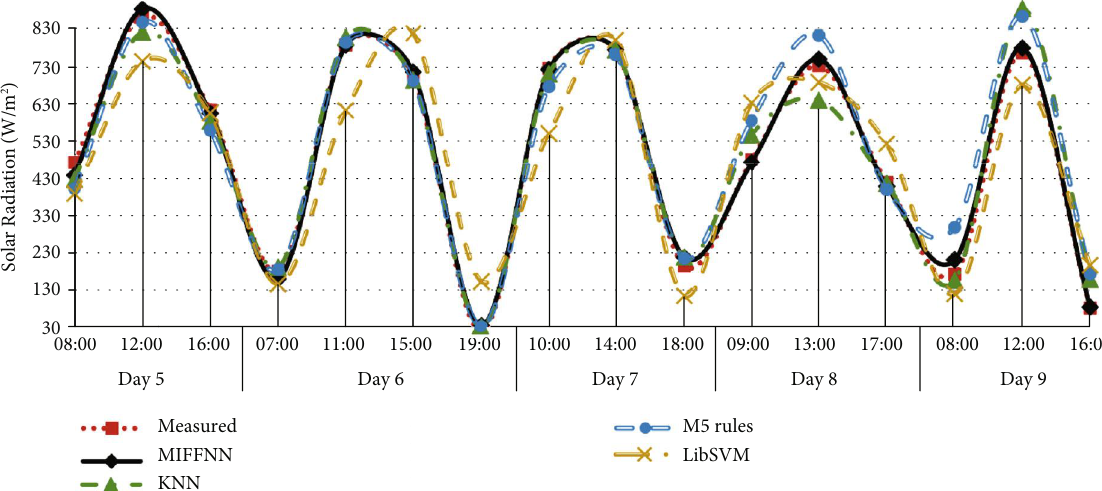
Figure 18: Comparative performance plot of ML algorithm models measured and estimated by using fi ve-day input data from July 2004 in Kahramanmaras according to HAGSR results.